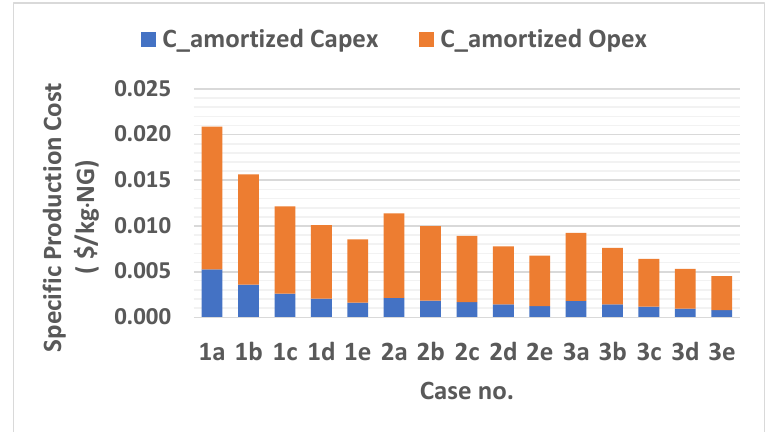
Figure 8. Specific production cost for each case study.